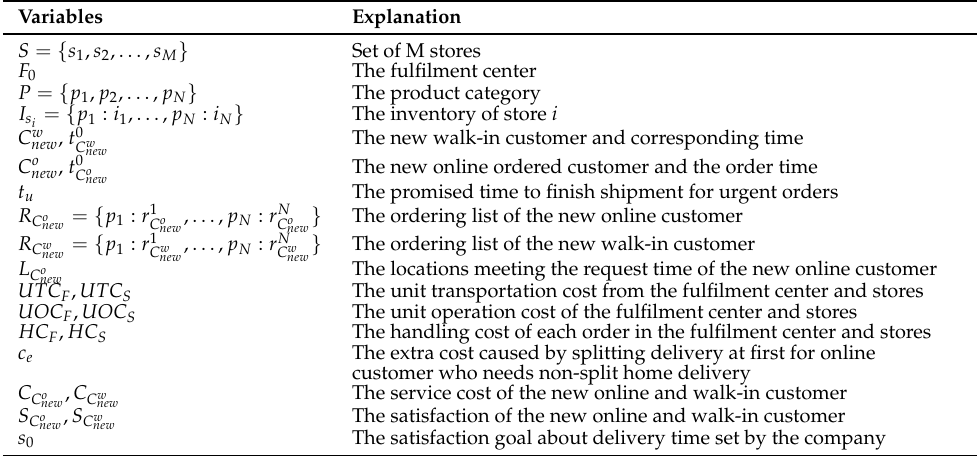
Table 3. Variables of the defined